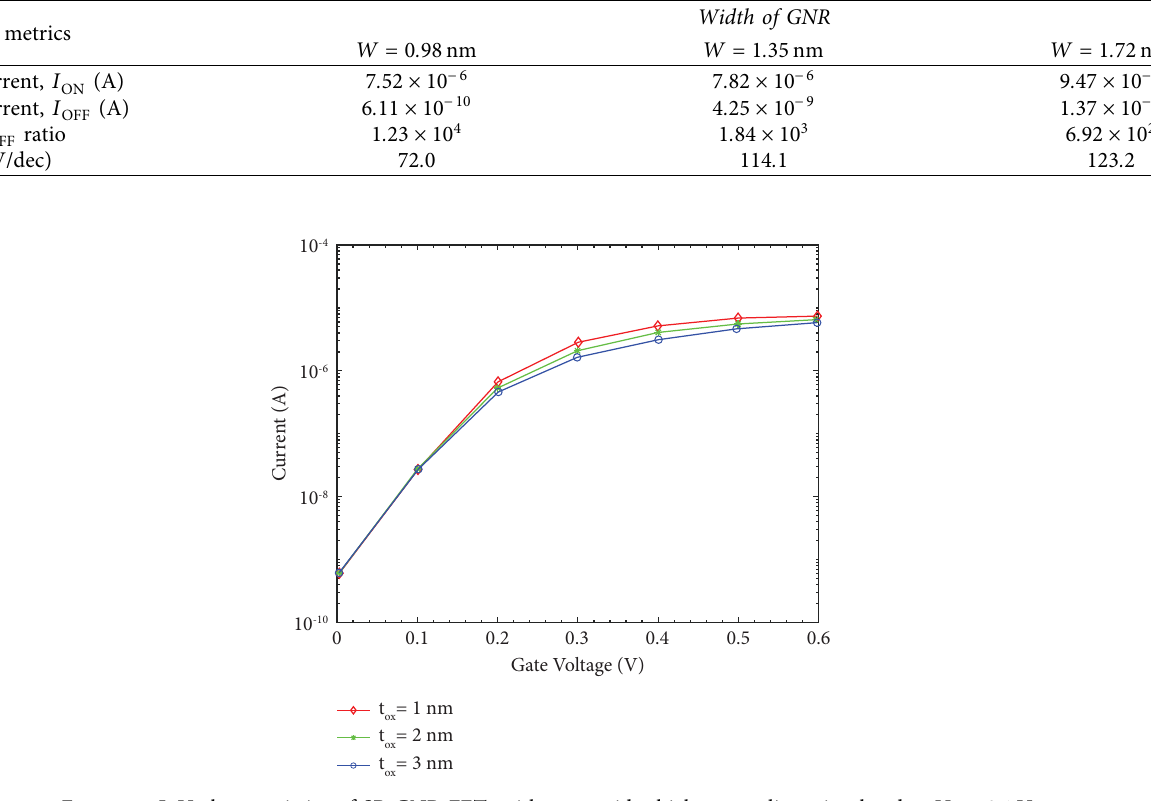
Figure 5: I–V characteristics of SB-GNR-FETs with gate oxide thickness scaling, simulated at V